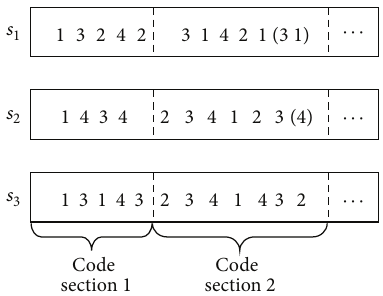
Figure 6: Encoding method.